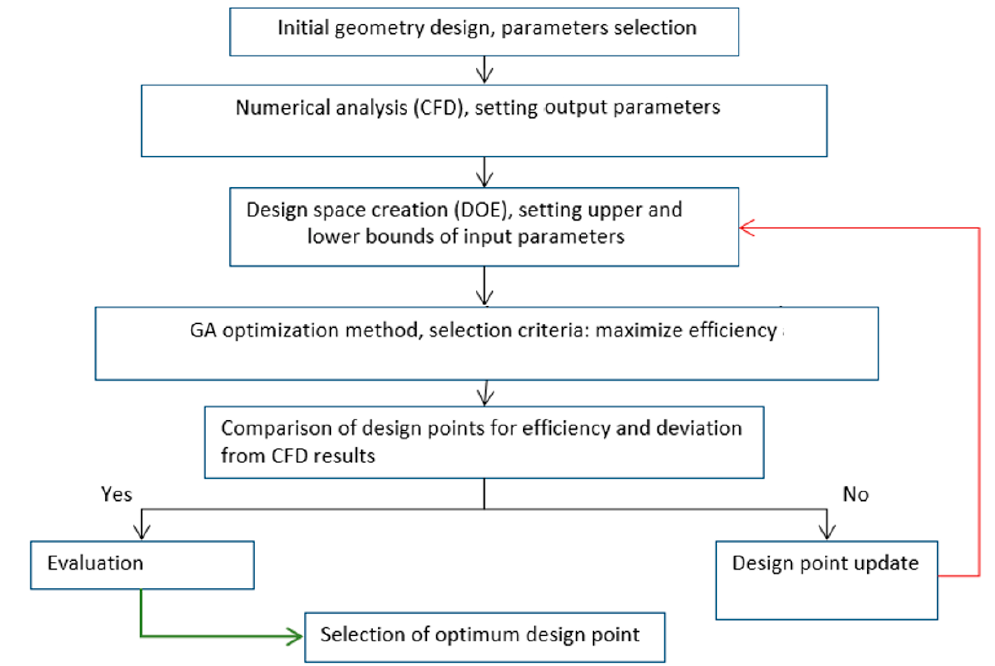
Figure 8. Design optimisation process.